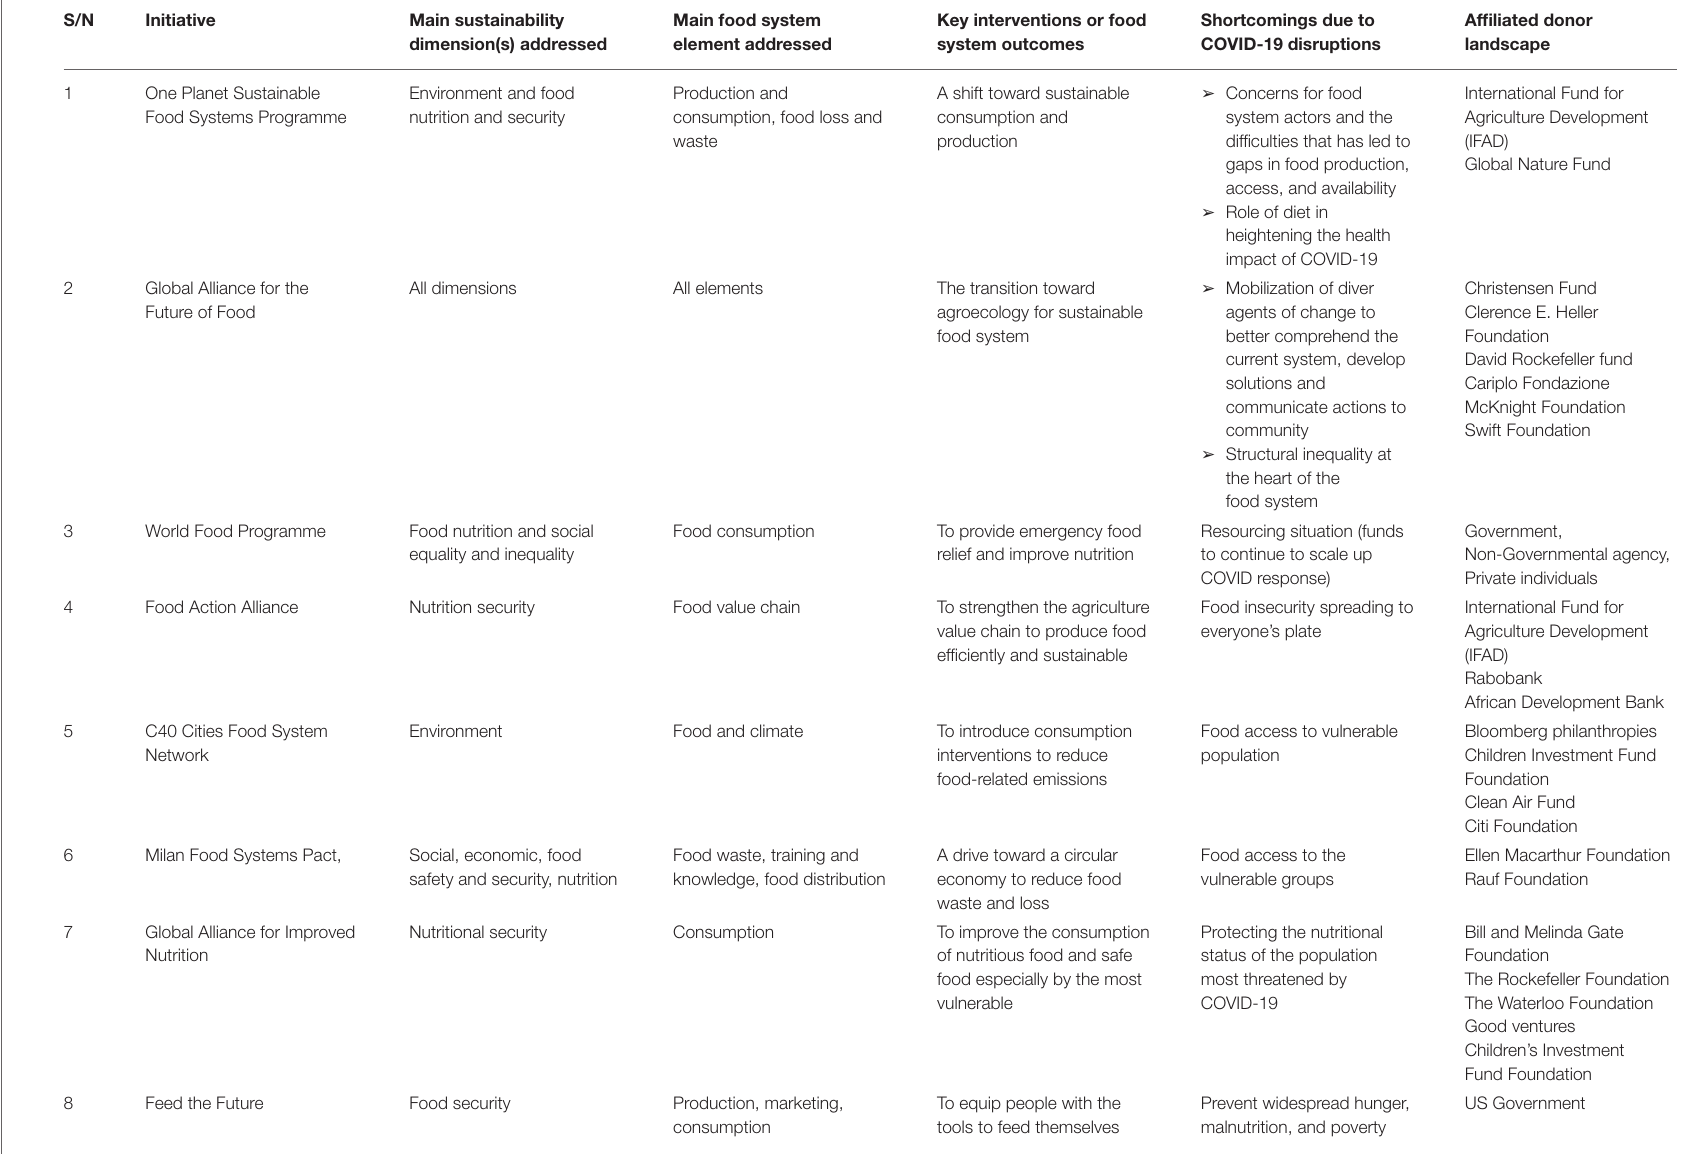
TABLE 7 | Summary of the different initiatives in relation to sustainable food system.